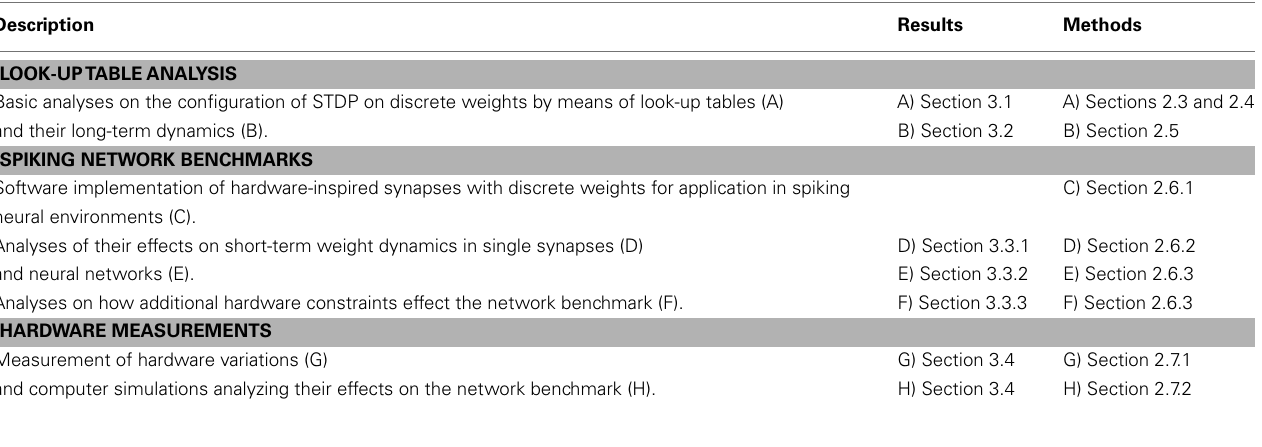
Table 3 | Outline of analyses on the effects of weight discretization and further hardware